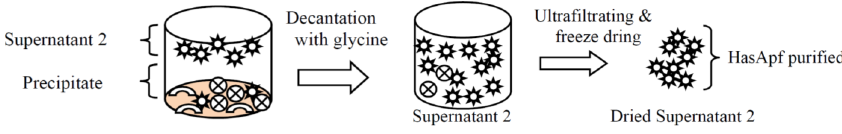
Table 1. Relation of the amount of bacteria to the kinetic resolutions of rac ‐ 2 for each fraction. Process (each fraction)